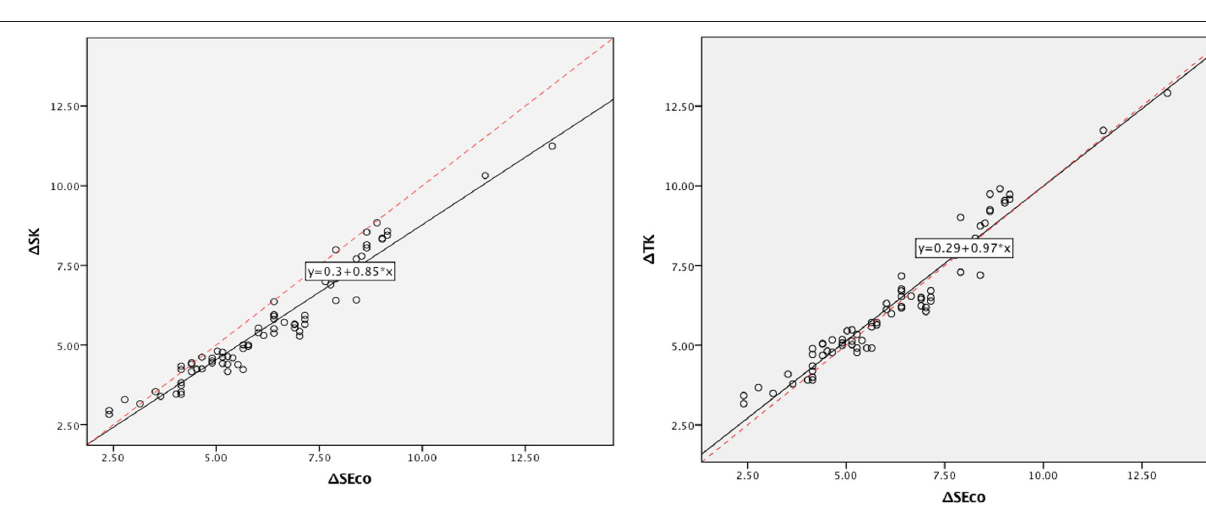
FIGURE 3 | Linear regression analysis on 1 SEco and 1 SK, and 1 SEco and 1